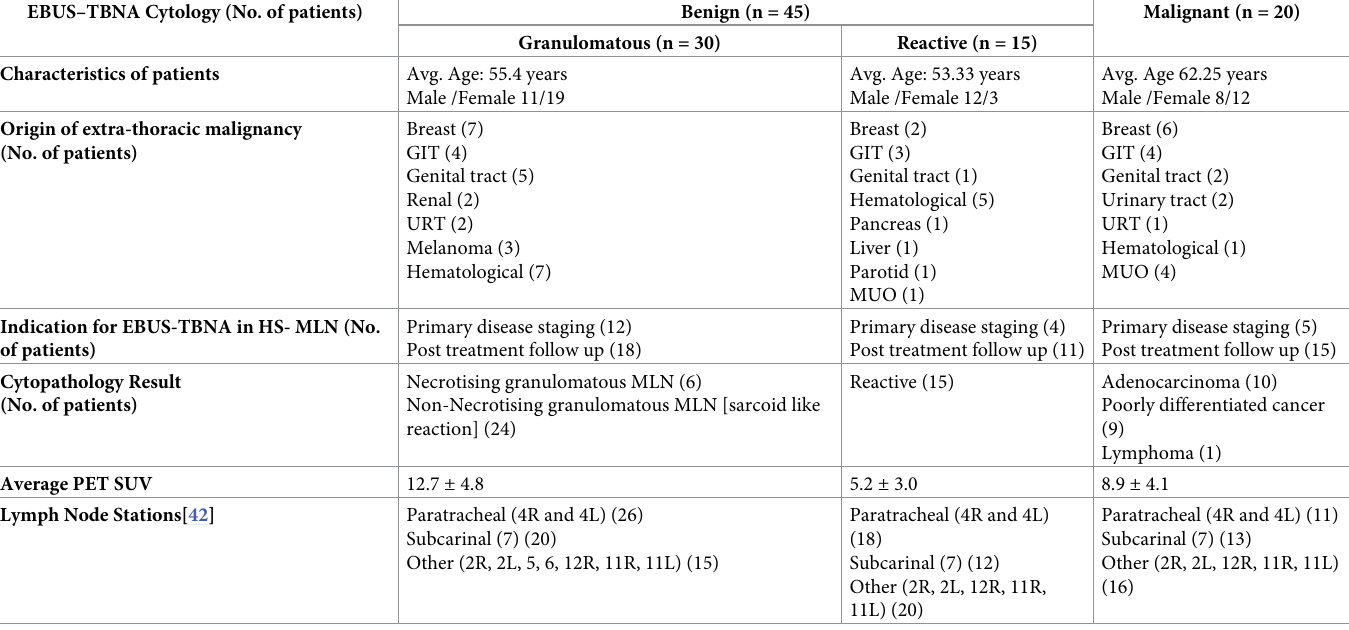
Table 1. Details of 65 study patients. (n- no. of samples, Avg.: Average, GIT: Gastrointestinal tract, URT-Upper respiratory tract, MUO- Malignancy of unknown origin). EBUS–TBNA Cytology (No. of